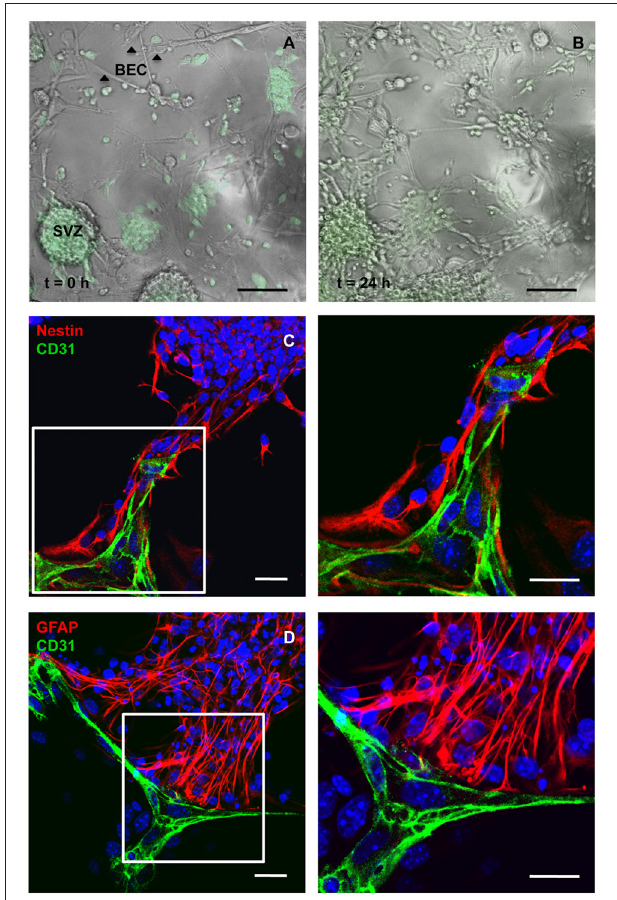
FIGURE 1 | Cocultures of SVZ cells and BEC. Representative transmission and fluorescence digital images of a BEC and GFP-expressing SVZ neurospheres coculture at the beginning of the coculture (A) and after 24 h (B) . Scale bars, 100 µ m. (C,D) Confocal digital images of a 24 h coculture of CD31 + BEC (green) and SVZ cells showing Nestin + immature cells (red, C ) and GFAP + astrocytes (red, D ) contacting BEC. Nuclei are stained with Hoechst 33342 in blue. Fluorescent images at the right are magnifications of fields shown in the left figures. Scale bars, 20 µ m.